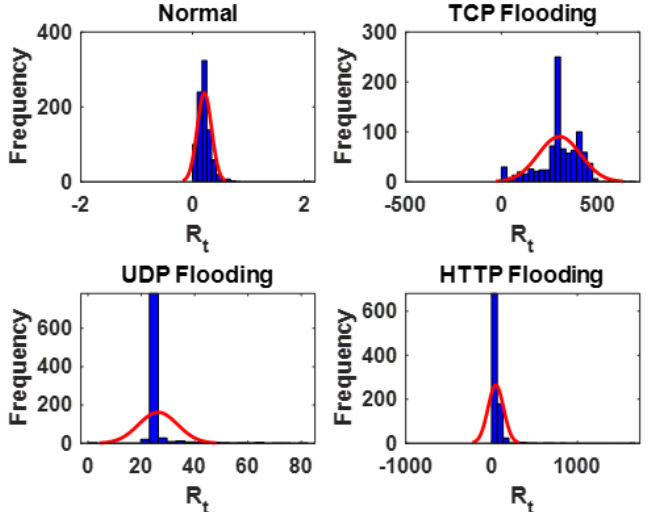
Figure 6. The distributions of R t metrics for various SDN